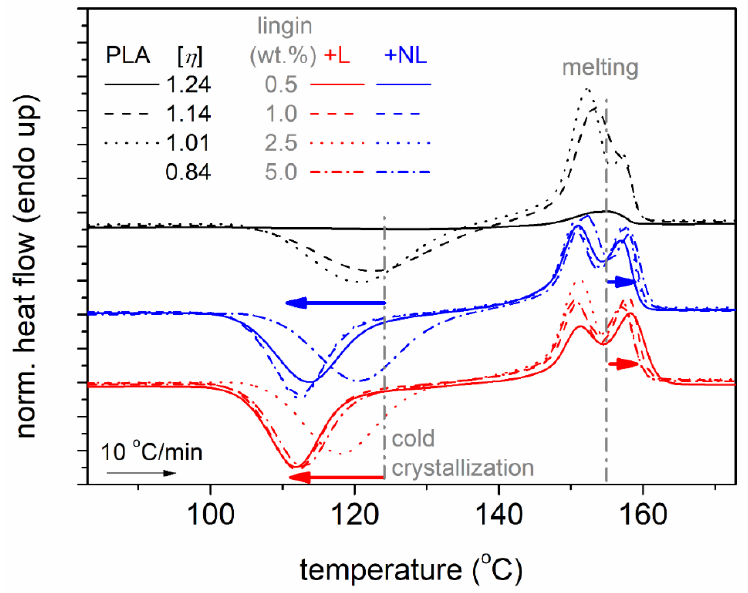
Figure 5. DSC heating traces for all samples, composites, and neat PLAs, described in a plot, focusing on the temperature regions of cold crystallization and melting. The added arrows mark the effects imposed by -NL and -L.